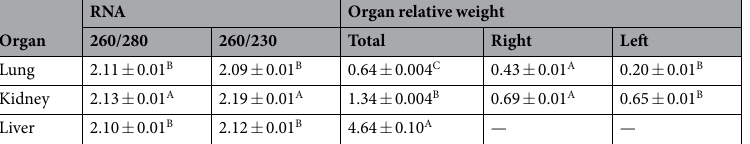
Table 2. Ischemia time independent variables. Model results are expressed as mean ± standard error for each variable of interest. Different superscript letters indicate Fisher’s least significant difference (p < 0.05) using Bonferroni adjusted p-values for mean comparison. Note that “—” indicates result not available for the organ. RNA 260/280 and 260/230 are the RNA absorbance ratios at 260 nm/280 nm and 260 nm/230 nm,